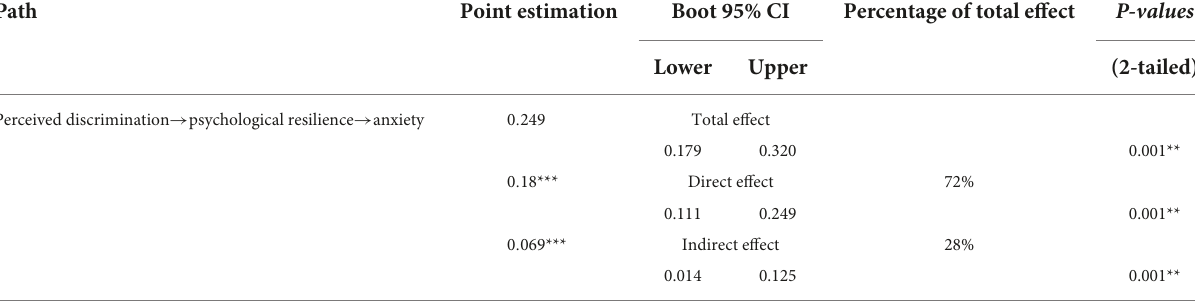
TABLE 4 The mediating effect of psychological resilience between perceived discrimination and anxiety.